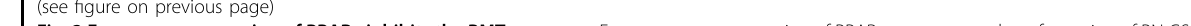
Fig. 3 Exogenous expression of PPAR γ inhibits the PMT process. a Exogenous overexpression of PPAR γ suppresses sphere formation of PN GSCs. PN GSCs were infected overnight with adenovirus expressing control vector (pAd-Dest) or PPAR γ (pAd-PPAR γ ) followed by 10 μ M pioglitazone treatment for 3 days. Sphere forming ability (upper) or quanti fi cation of sphere number (lower) is represented. Data represent the mean ± S.E.M. ( n = 5). Asterisks are references as follows: *** P < 0.001, and **** P < 0.0001 (one-way ANOVA, Tukey ’ s post hoc test). b , c Gene expression for GBM biomarkers or cell cycle regulation. b mRNA expression of p21, Olig2, Bcl2a1, and CD44. c Immunoblot assay for cell cycle proteins. PN GSCs were infected overnight with adenovirus expressing control vector (pAd-Dest) or PPAR γ (pAd-PPAR γ ), which was followed by 10 μ M pioglitazone treatment for 24 h. Data represent the mean ± S.E.M. ( n = 3). d Immunoblot analysis of CD44 and SOX2 in PN and MES GSCs infected with pAd-Dest control or pAd-PPAR γ for 2 days. e PMT assay upon PPAR γ overexpression. Expression of PN and MES markers was analyzed in PN cells infected with pAd-Dest control or pAd-PPAR γ with/without TNF α treatment. PN GSCs were treated daily with 50 ng/ml TNF α for 4 days in the presence of adenovirus expressing pAd-Dest control or pAd-PPAR γ . Immunoblot assay of PPAR γ , CD44, and SOX2 (left) or qPCR analysis of PPAR γ and multiple MES markers, CD44, PAI1, and BCL2A1. Data represent the mean ±